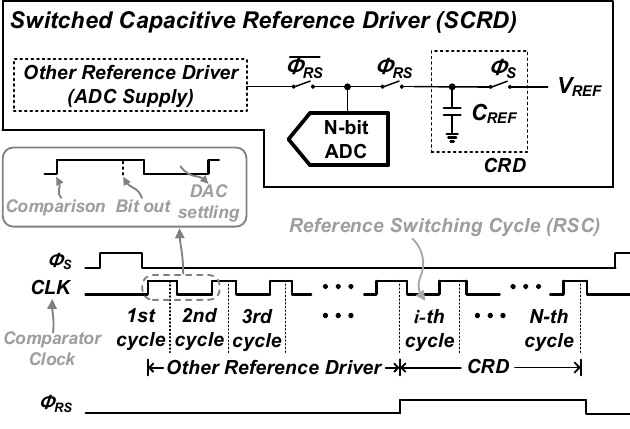
Figure 4. The block and timing diagram of the proposed SCRD.